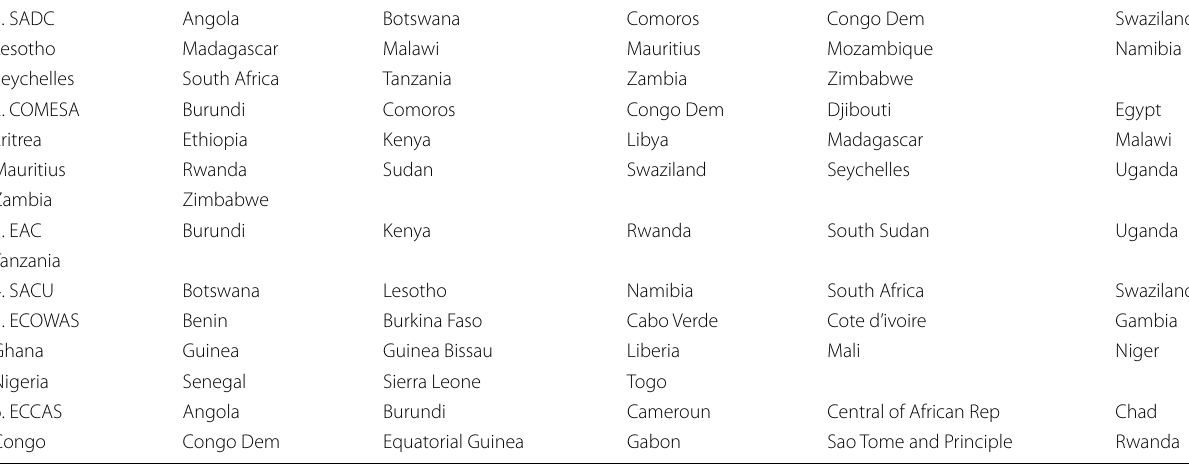
Table 7 Members of African Regional Economic Communities. Source : Author’s computation from various sources 1. SADC Angola Botswana Lesotho Madagascar Malawi Seychelles Burundi Mauritius Rwanda Zambia Zimbabwe 3. EAC